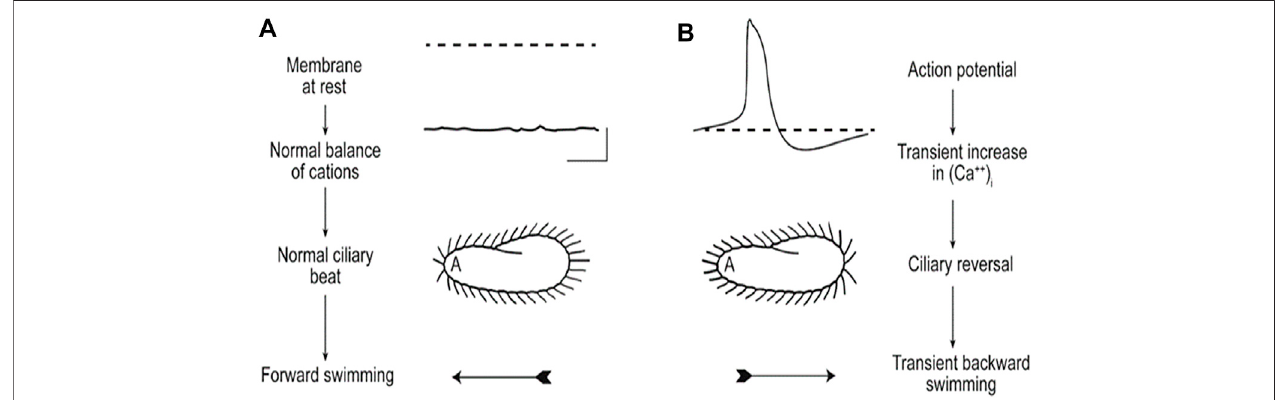
FIGURE 3 | These images illustrate (A) that the resting membrane potential of Paramecium is negative; the ciliary beat is toward the posterior and cell swims forward. (B) Indepolarizingconditions,suchashighKorBasolutions,thecell ’ smembranedepolarizesandreachesthresholdfortheactionpotential,duringwhichCa 2+ enterstheciliumthroughCa V channelsandtheCa 2+ changesthepowerstroketowardtheanterior,movingthecellbackward.Theactionpotentialisquicklyterminated, returned to resting V m levels, and the extra Ca 2+ removed (Kung et al.,